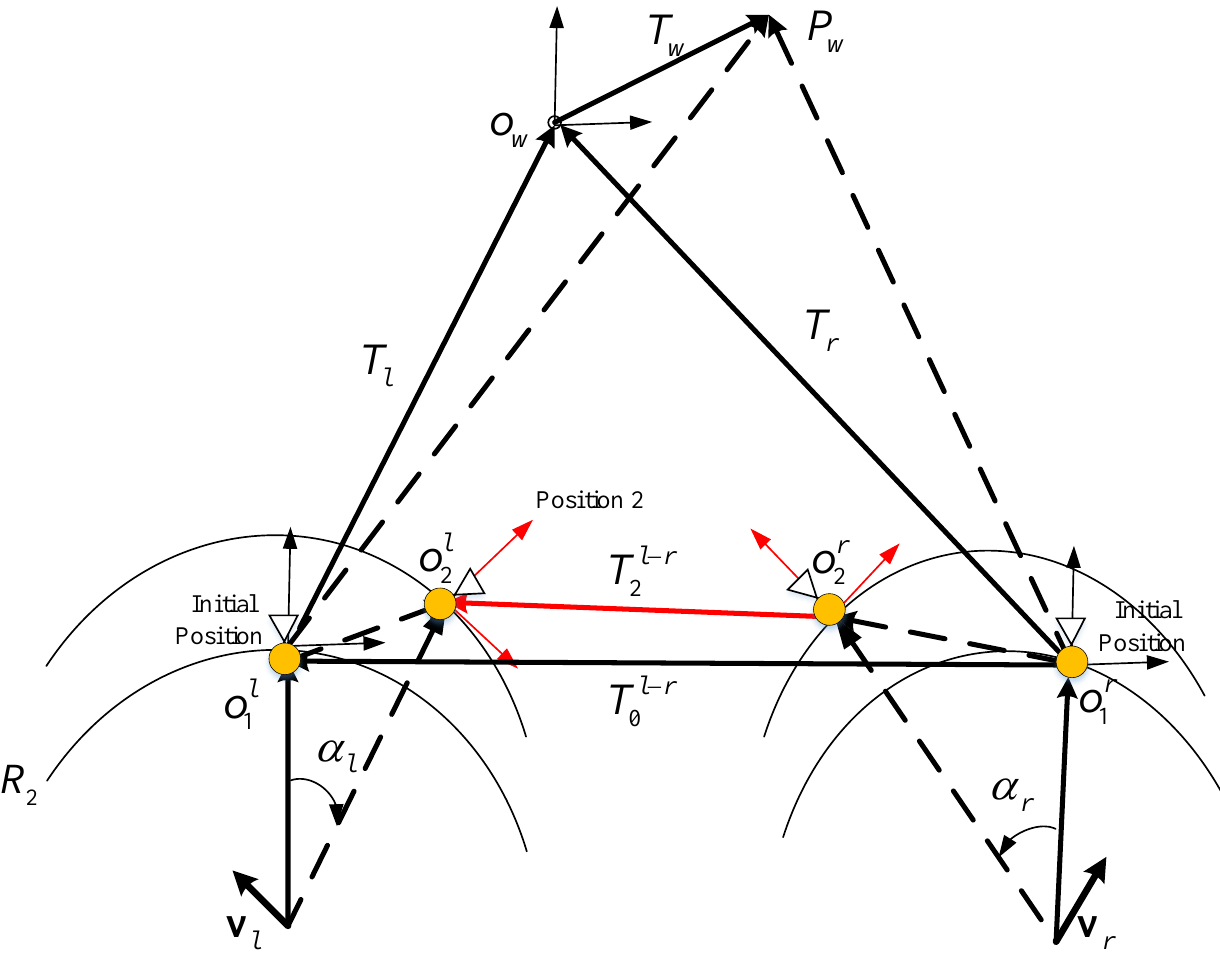
Figure 3. Schematic diagram of extrinsic parameter variations caused by camera rotation and zoom. Through the rotation and zoom, the optical centers move from the initial position, 1 o , to position o . 2